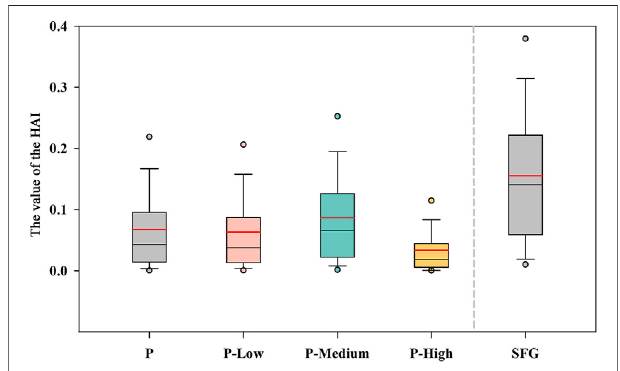
FIGURE 6 | The boxplots depict the human activity intensity (HAI) under different thawing hazard levels in the frozen ground of the Qinghai – Tibet Plateau. The gray boxes represent the HAI statistics of the permafrost (P) and seasonallyfrozenground(SFG)regions,thecoloredboxesrepresentthe HAIstatisticsunderdifferentthawinghazardinthepermafrostregions,andthe red line shows the average.